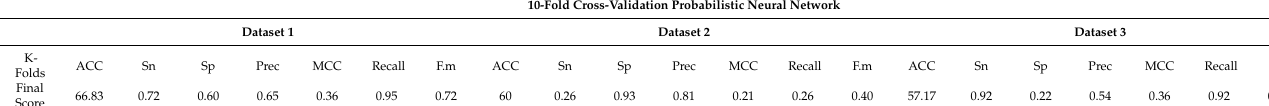
Table 3. 10-fold cross-validation Result for Probabilistic neural network.